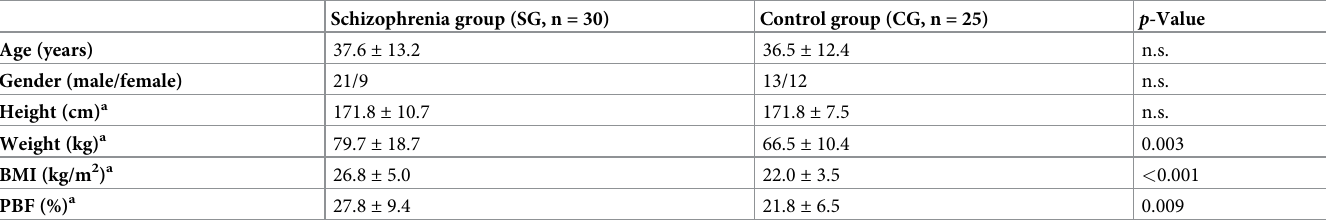
Table 1. Demographics, anthropometrics, and body composition characteristics of patients with schizophrenia and healthy controls. Schizophrenia group (SG, n = 30) Control group (CG, n = 25)